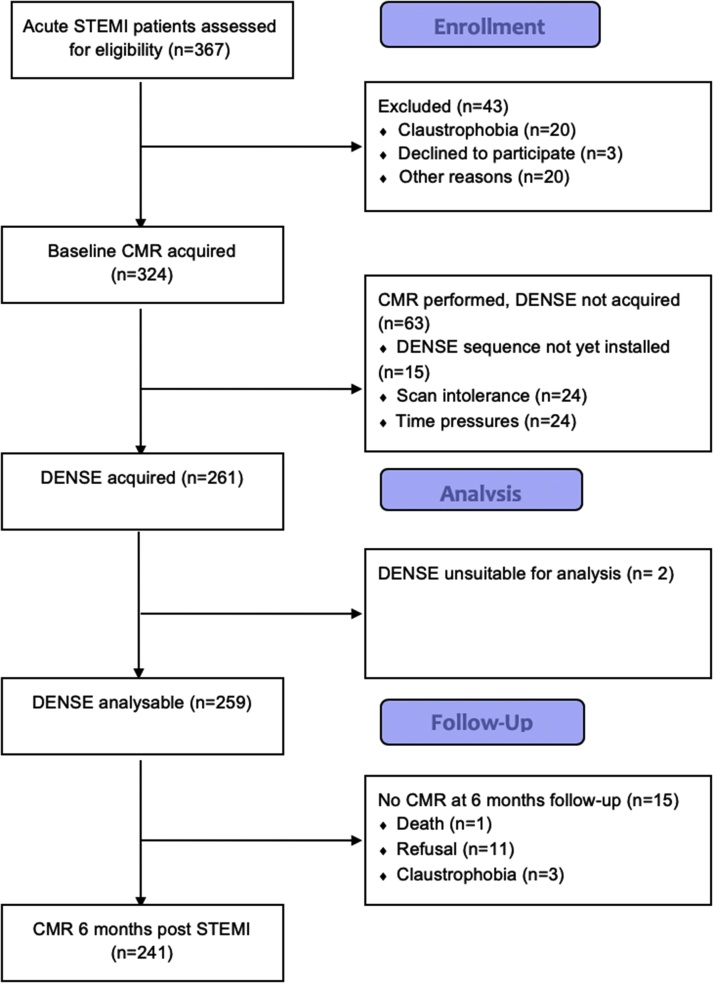
Study flow diagram.